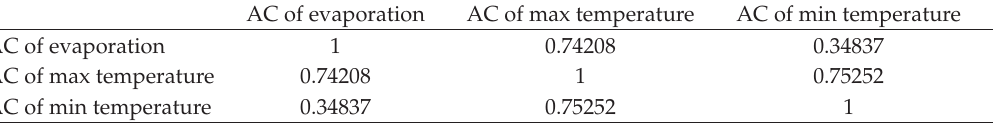
Table 4: Correlation Coe ffi cients among the annual cycles (cid:2) ACs (cid:3) of three climate signals. AC of evaporation AC of max